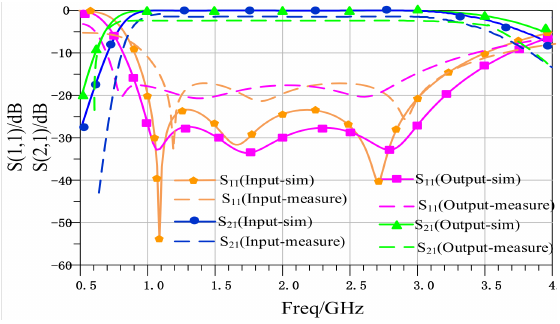
Figure 9. S-parameter simulation and measure results.